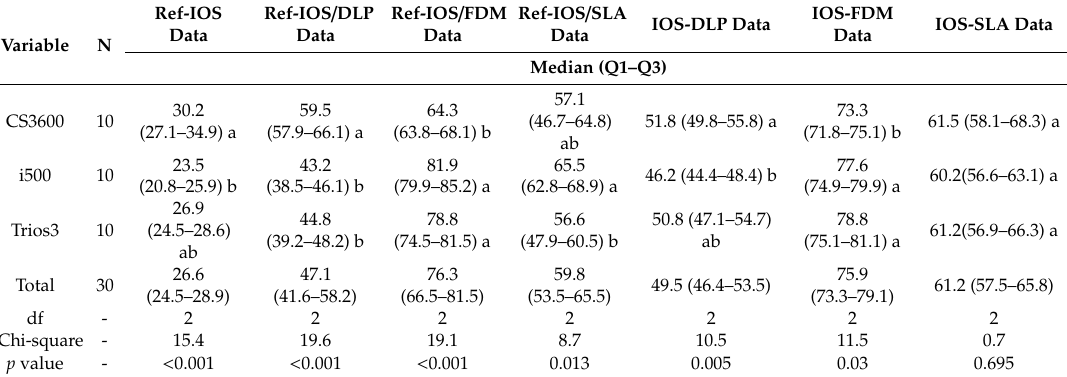
Table 3. Comparison of median trueness values by all data capture principle (unit: µ m).